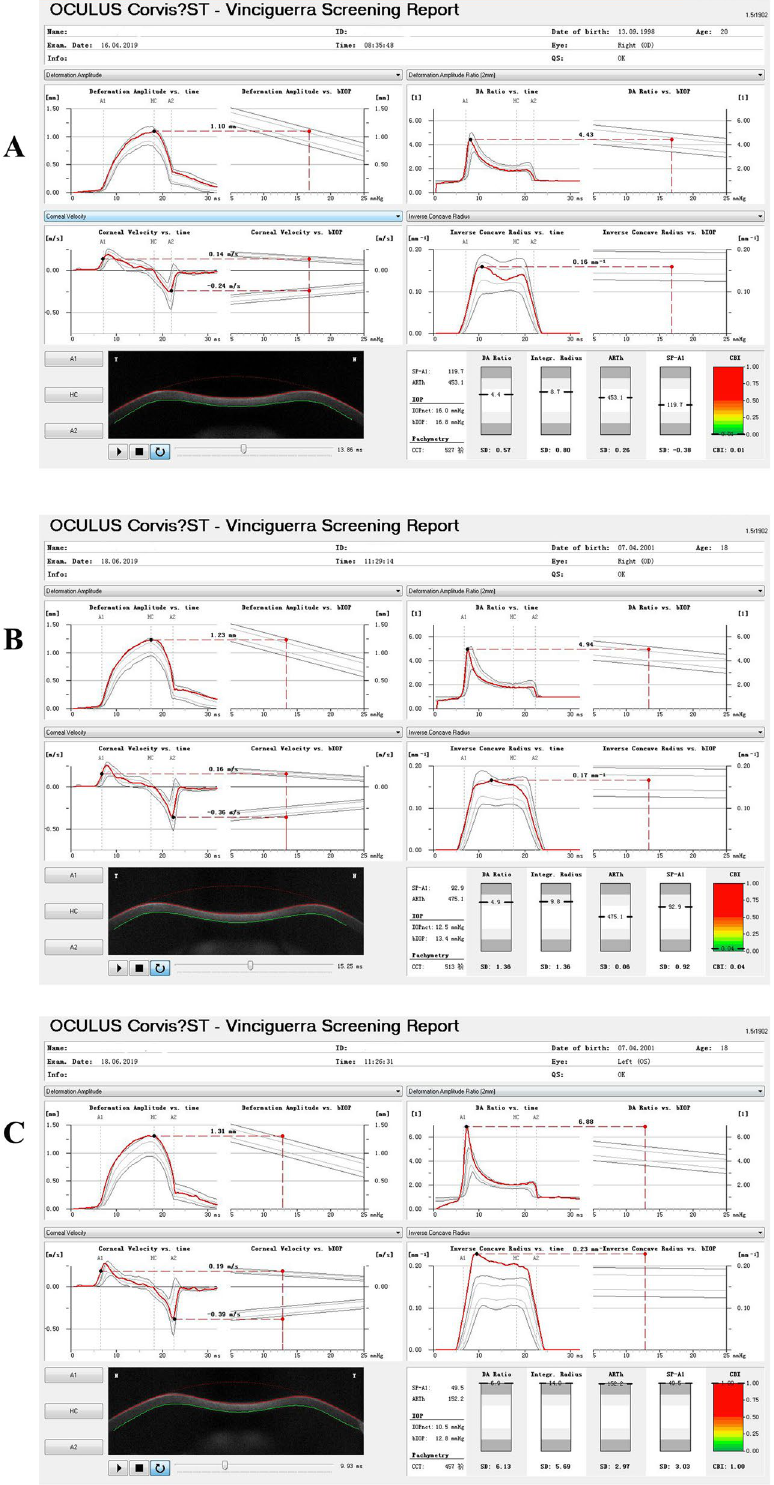
Figure 1. New parameters measured by Corvis ST. ( A ) control eyes; ( B ) SKC eyes; ( C ) KC